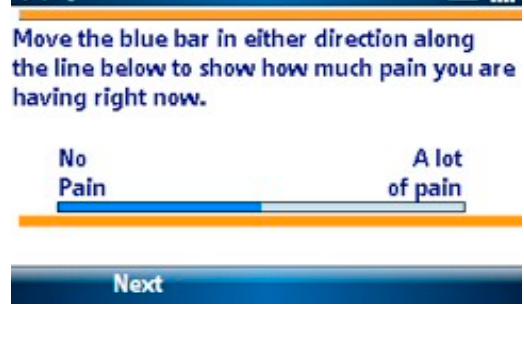
Figure 1. Pain Intensity Screen.